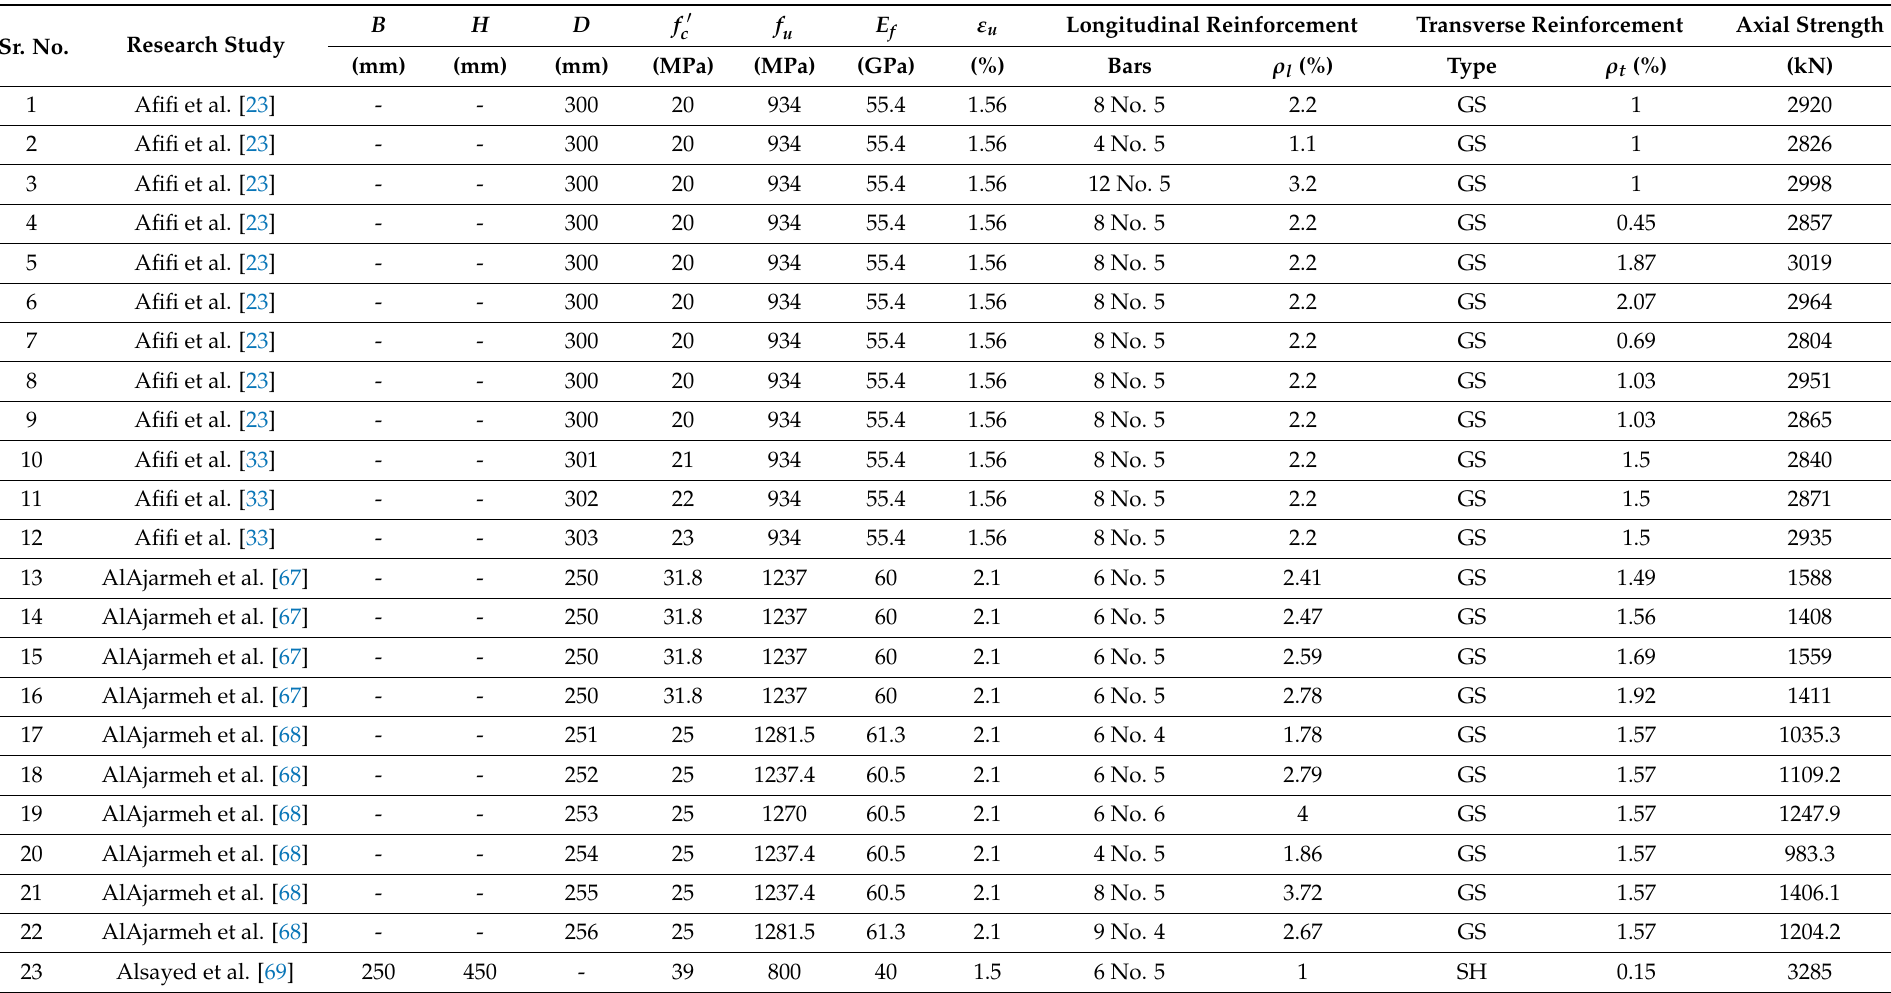
Table A1. Constructed experimental database (GS = GFRP spirals, GH = GFRP hoops, SS = steel spirals, SH = steel hoops, N = no lateral